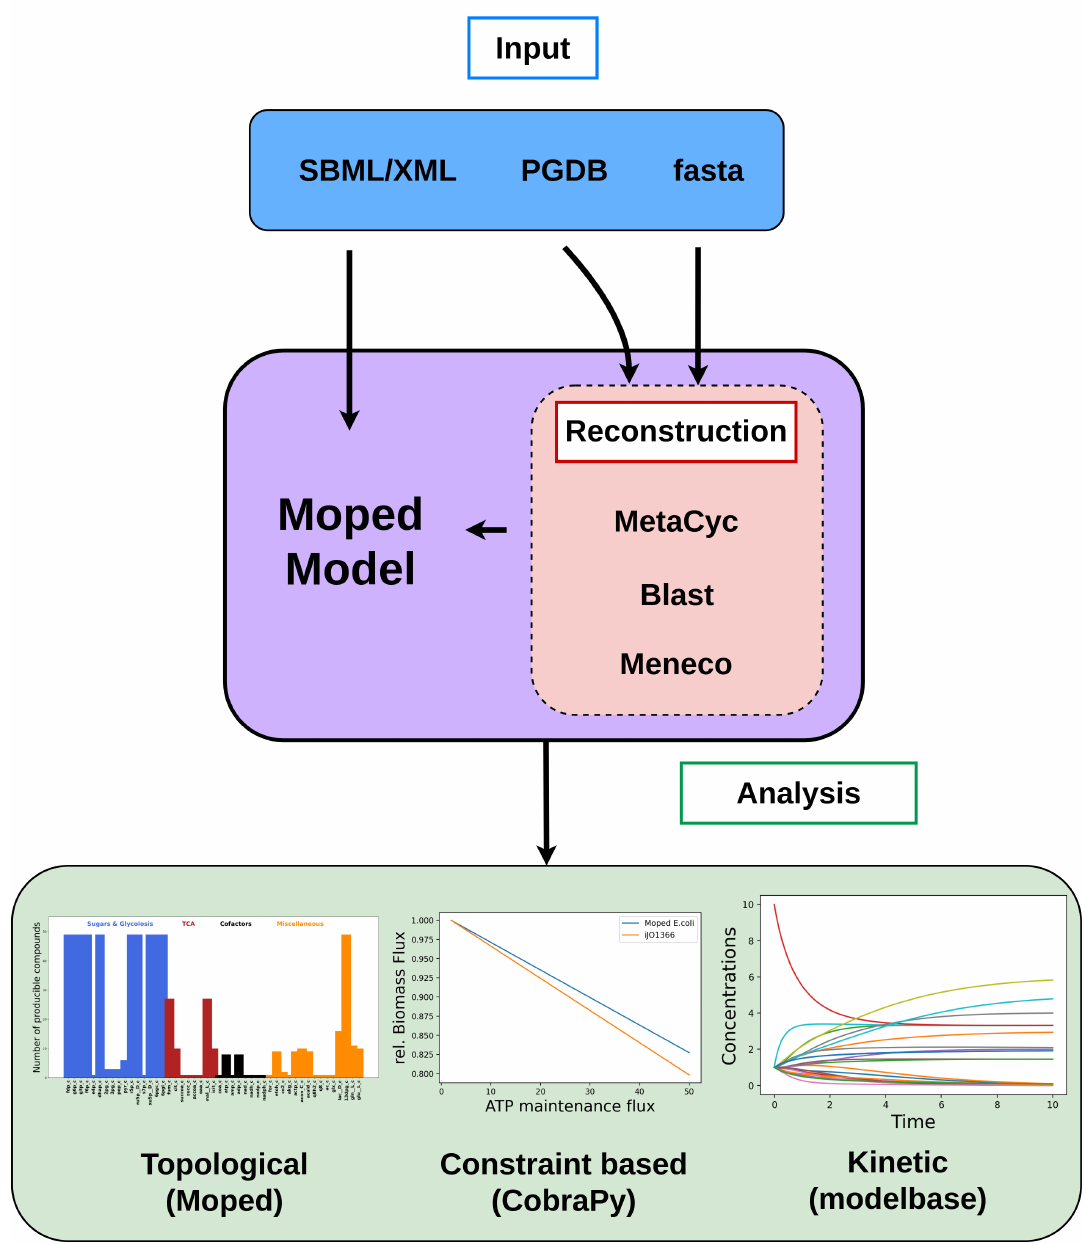
Figure 1. The modeling hub moped. moped accepts SBML, FASTA files or MetaCyc and BioCyc PGDBs as inputs. PGDBs and SBML files are directly converted into a moped object. By BLASTing genome/proteome-sequences against MetaCyc, moped models can be constructed utilizing GPR rules. Further reconstruction can be achieved using Meneco for gap filling. Topological model analysis is implemented in moped. For constraint-based and kinetic analysis, moped offers export as CobraPy and modelbase objects, respectively